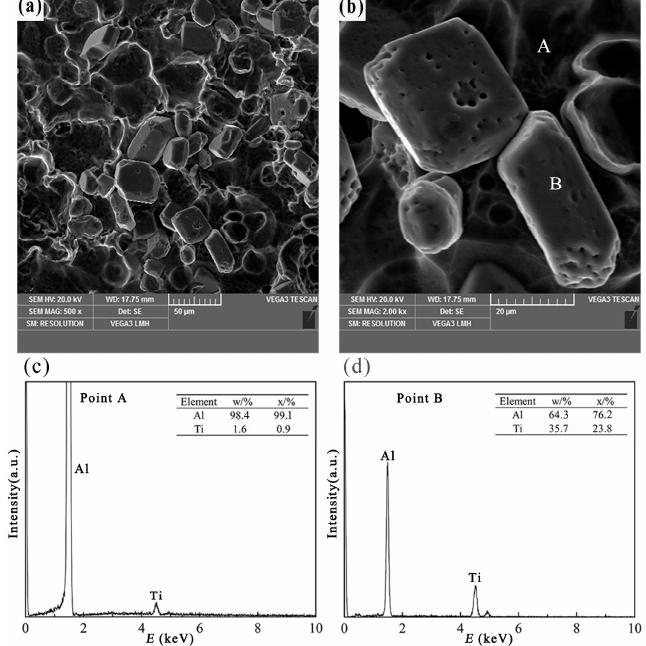
Figure 7. Three-dimensional morphology and point scan elements analysis of block-like TiAl 3 , ( a , b ) three-dimensional morphology of the blocky TiAl 3 particle; ( c ) EDS spectra of point A; ( d ) EDS spectra of point B.